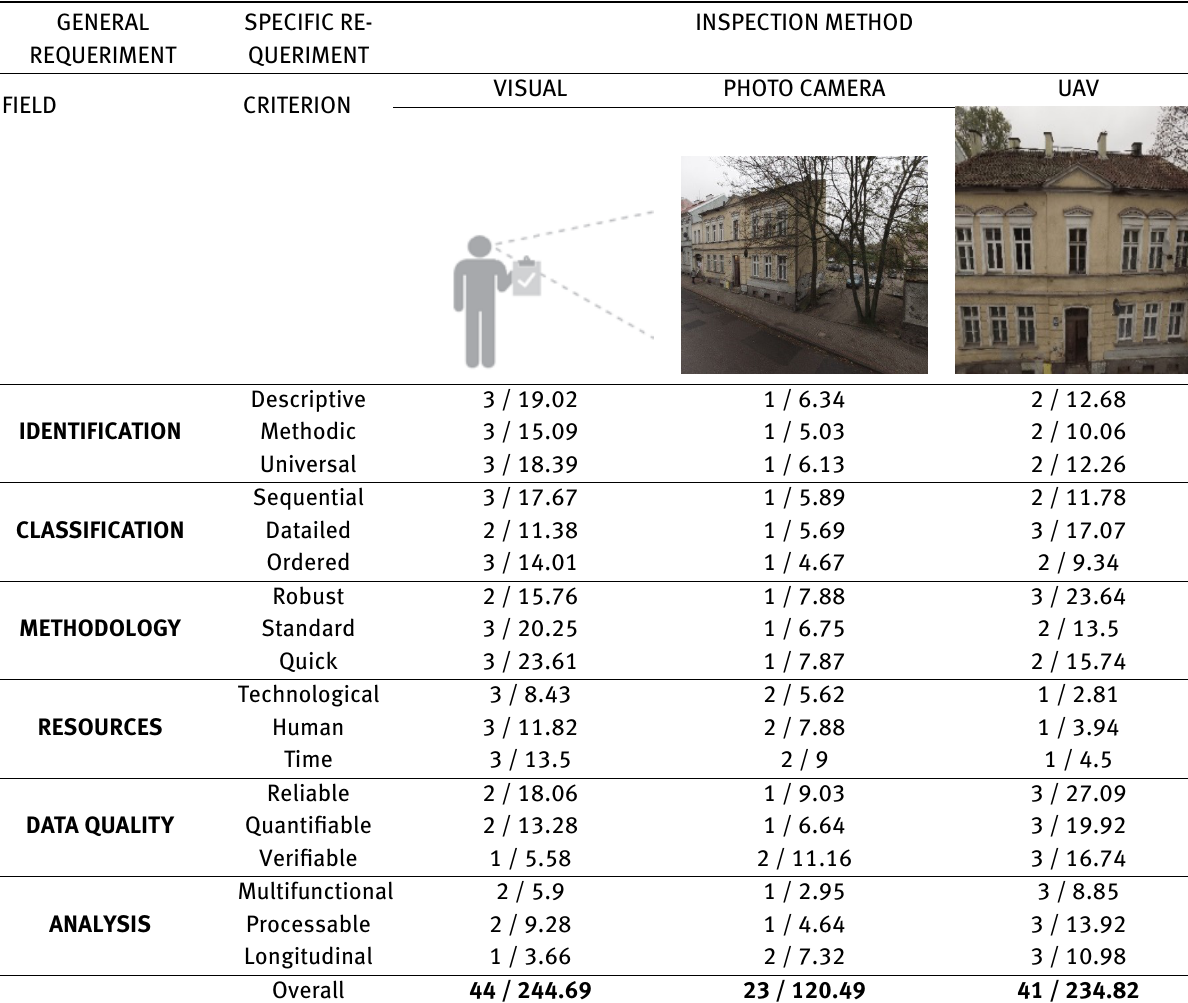
Table 2: Scored (absolute / weighted) values for the specific requeriments according to visual, photo camera and UAV inspection method-